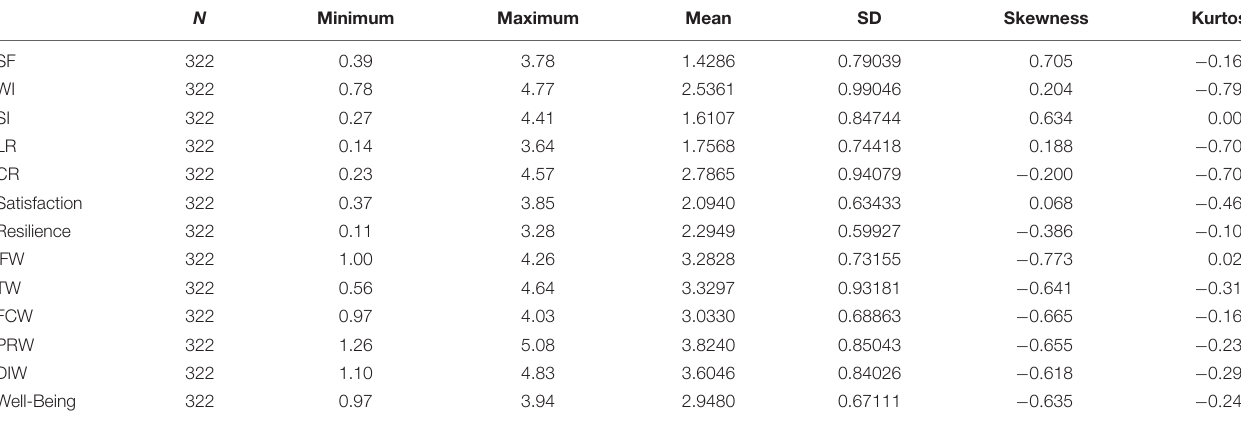
TABLE 3 | Descriptive statistics of the scores after regression imputation.